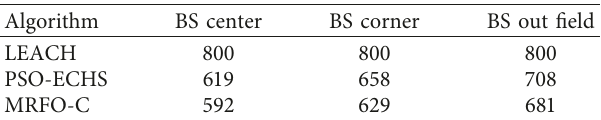
Table 4: Total energy consumption (in Joules) at round 5000 for 400-node network and 40 CHs.